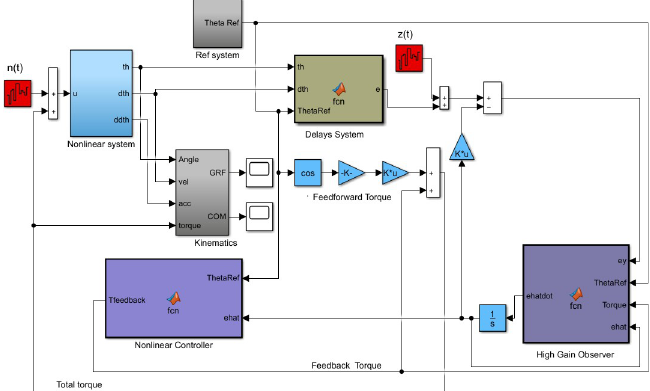
Fig 2. Sit-to-stand movement simulations developed in